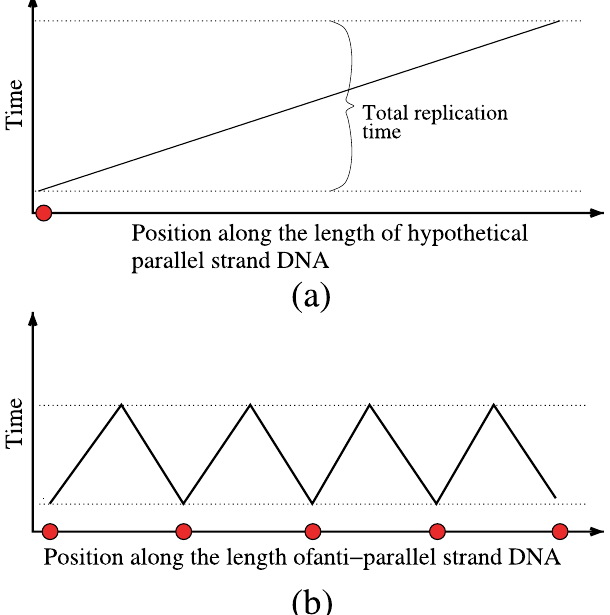
Figure 7. Schematic diagram illustrating the reduction in replication time of anti-parallel strands of appropriately chosen sequence compared to hypothetical parallel strand DNA. Points on X-axis denote the distance of an arbitrary location on the linear DNA strand from one of its ends. The schematic plots show the time at which a given location on the DNA is replicated. ( a ) In the hypothetical parallel-stranded DNA-like molecule, the double strand is constrained to unravel from only one of its two free ends, due to the lowering of kinetic barrier at that end through sequence–independent asymmetric cooperativity. This single origin of replication is denoted with a red dot on the X-axis above. Due to the sequential nature of unzipping of the parallel-stranded DNA-like molecule, locations farther from the origin would be replicated later, resulting in a replication time plot that increases monotonously with the distance from the origin. The straight line above schematically illustrates such a monotonically increasing replication time. ( b ) Anti-parallel double strand DNA offers the possibility of multiple origins, specified by sequences that have local dyadic symmetry, exemplified by palindromic sequences. These origins are denoted by multiple red dots on the X-axis. Disjoint segments are replicated simultaneously, and independently of each other, as shown by the multiple piecewise continuous lines representing each segment. These segments are called replichores in the literature. The replication time of anti-parallel strand DNA is reduced due to this parallelization of replication. Even though the sequence- independent asymmetric cooperativity of parallel-stranded DNA-like molecule is stronger, resulting in faster unzipping and hence possible faster movement of replication machinery along the strand, anti-parallel strands with slower rate of replication can overcome the competition by initiating replication at multiple locations, simply by acquiring sequences supporting multiple origins through evolutionary tinkering. To illustrate the above, the slope of the plot in ( a ) is drawn shallower, denoting faster rate of replication, compared to the slope of the plot in ( b ). It has to be noted that circular anti-parallel DNA strands need only one origin of replication to introduce two replichores or simultaneously replicating segments of DNA, and can reap the benefits of anti- parallel